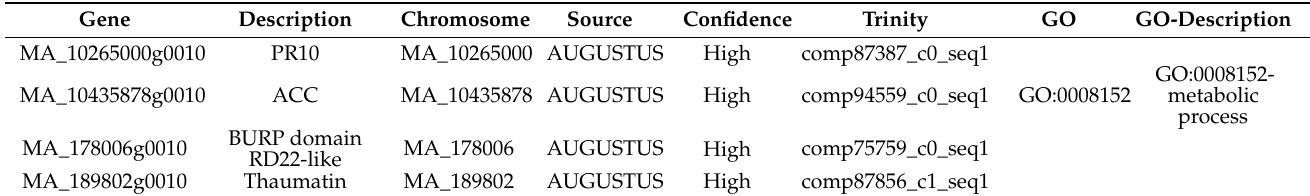
Figure 1. The gene expression levels of the four genes (( a ) MA_189802g0010, ( b ) MA_10265000g0010, ( c ) MA_10435878g0010 and ( d ) MA_178006g0010) found exclusively to be significantly expressed only under drought (compared to (+) group non-treated). Table 2. Four Drought-related Candidate Genes, their Description and GO